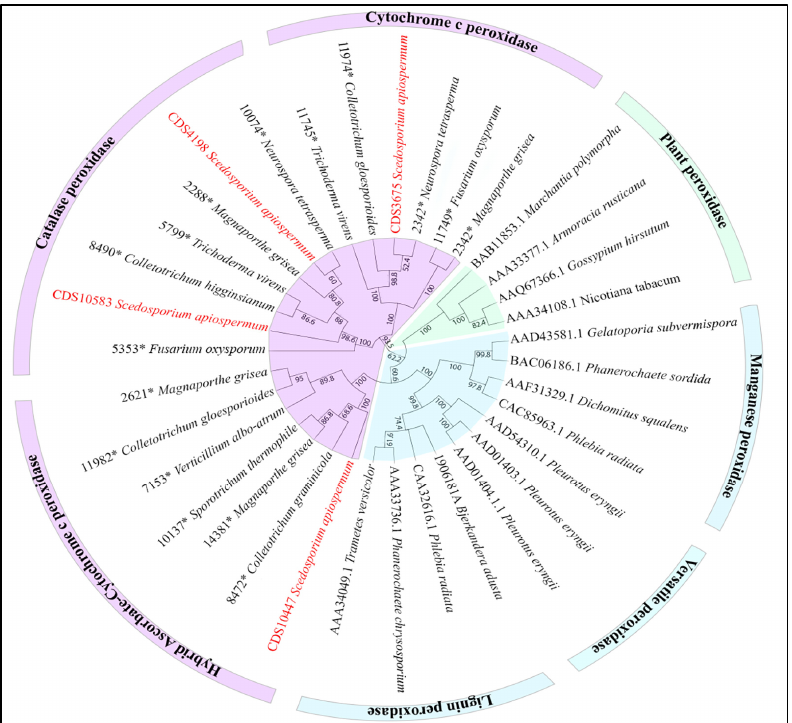
Figure 5. Classification of candidate enzymes among fungal peroxidases. An alignment of the protein sequences was created using the default settings for multiple alignments. Phylogenetic trees were constructed by the neighbor-joining method with cladogram presentation. Bootstrapping was carried out with 500 replications. Class I peroxidases are colored in pink, class II in blue and class III in green. Genes studied within Scedosporium species are marked in red. * Identification number from RedoxBase.